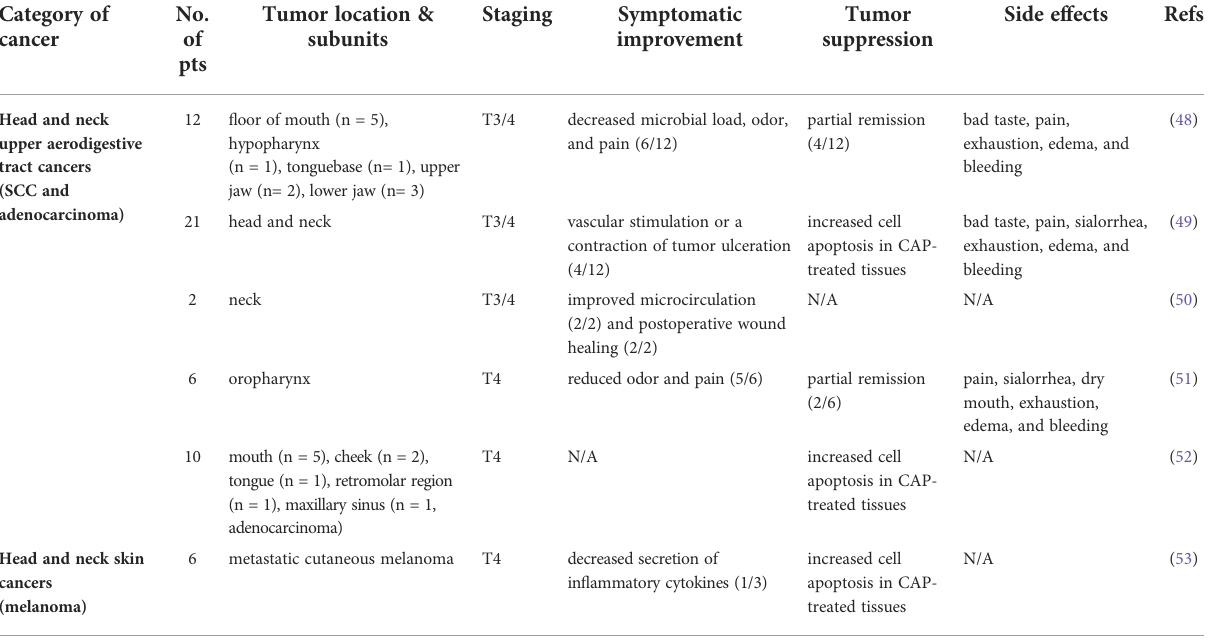
TABLE 3 Recent preclinical and clinical trials of CAP treatment in head and neck cancer. Category of